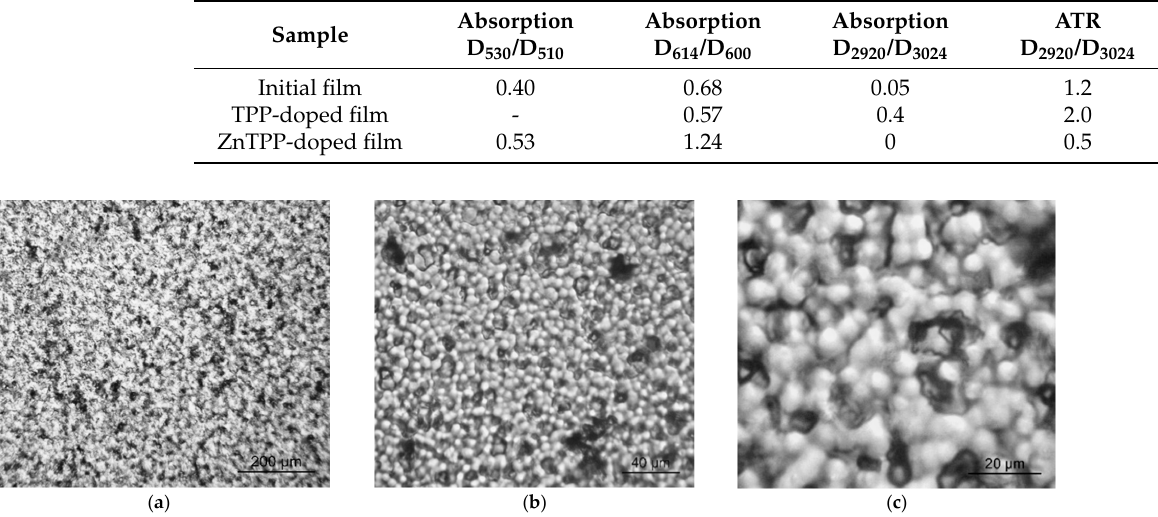
Figure 4. Optical micrographs of TPP ‐ doped P(VDF ‐ HFP) film (magnification ×100 ( a ), ×400 ( b ) and ×1000 ( c )). Table 2. Intensity ratio of a number of bands in the IR spectra of doped P(VDF ‐ HFP) copolymer films crystallized from acetone.